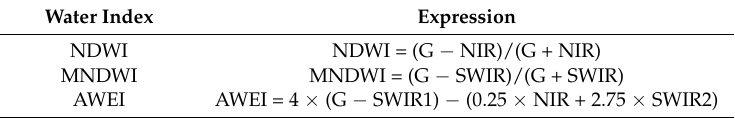
Table 1. Classical Water Area Indexes. G: Green band radiation; NIR: Near-infrared radiation;